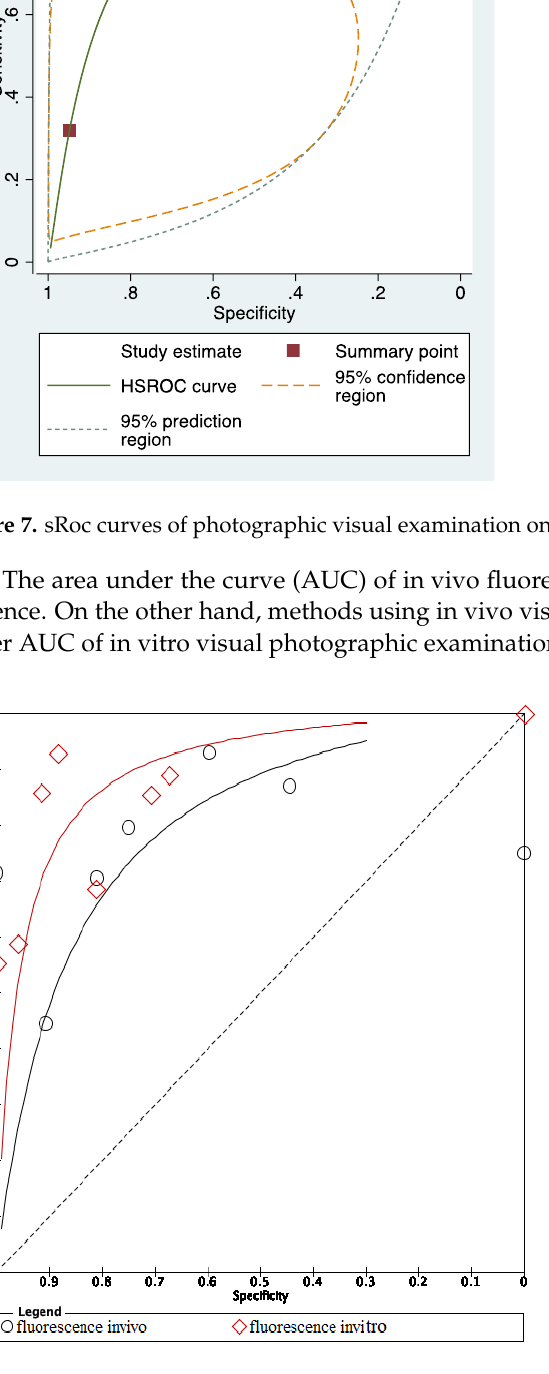
Figure 8. Comparison between in vitro and in vivo of fluorescence methods.